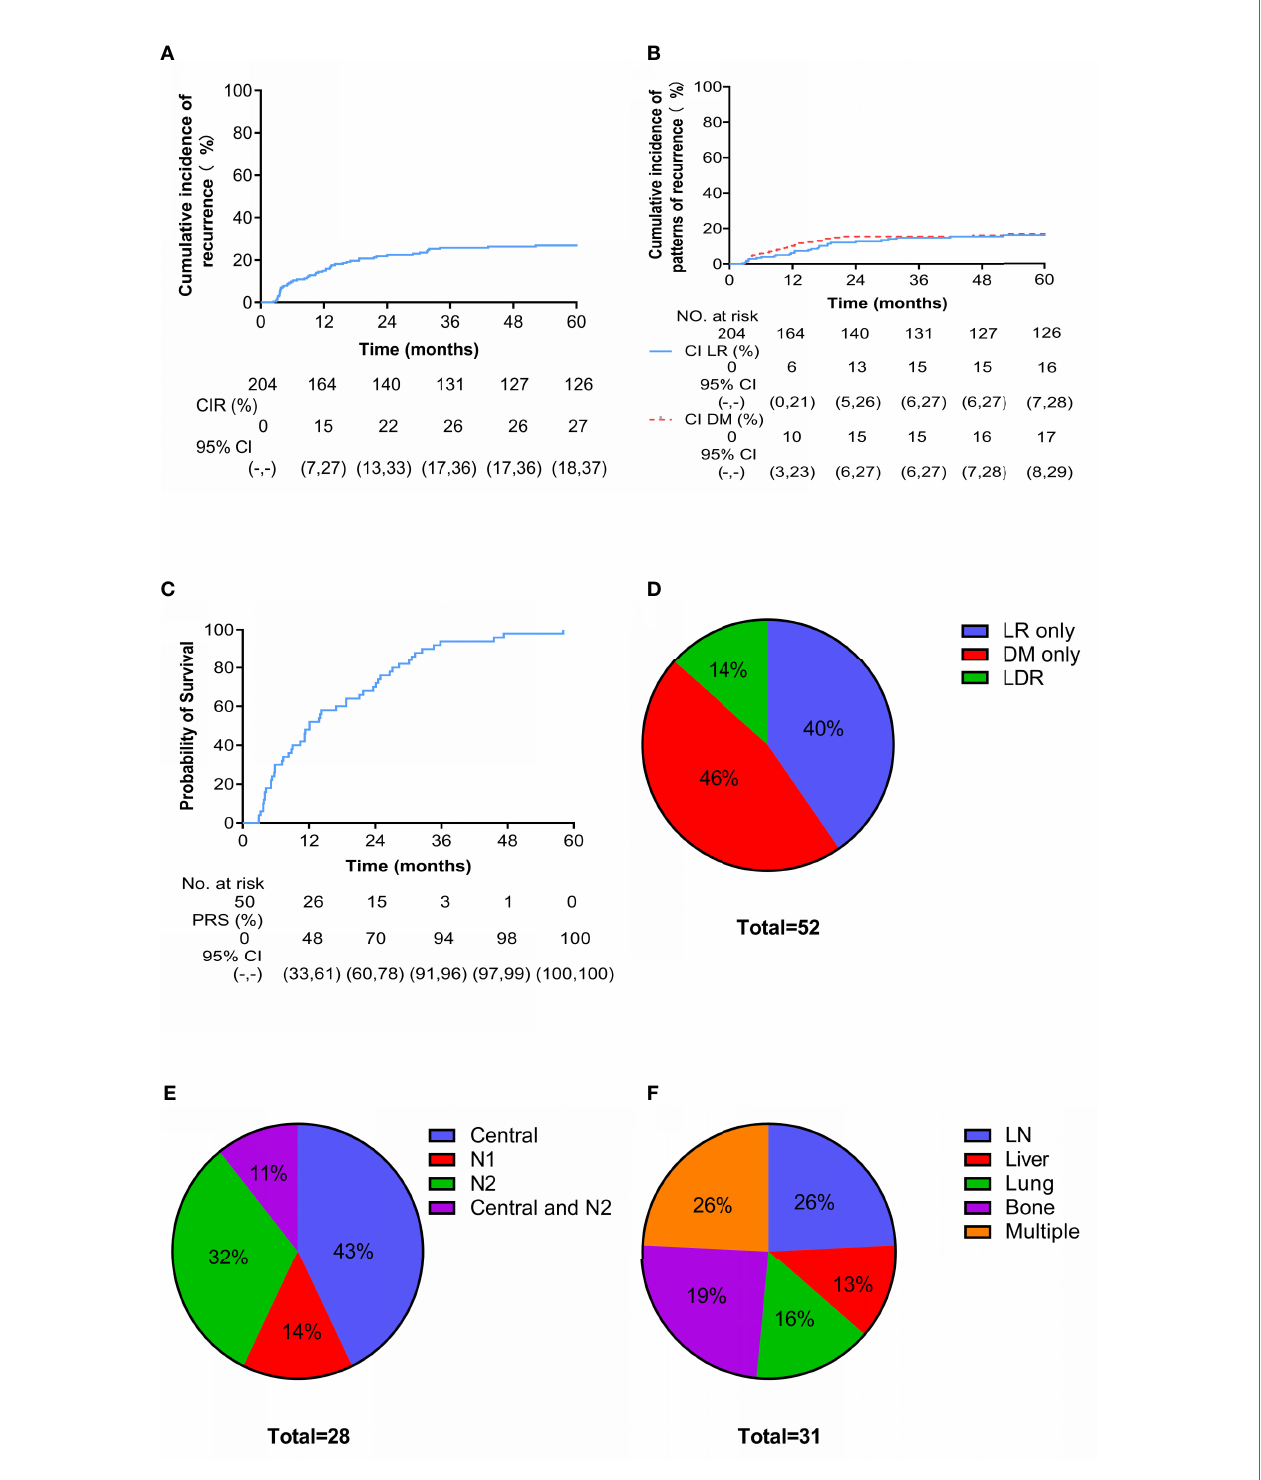
FIGURE 2 | Cumulative incidence and patterns of recurrence. Cumulative incidence of (A) overall recurrence and (B) locoregional (LR) versus distant metastasis (DM) since treatment. Cumulative incidence of (C) death after recurrence. Site-speci fi c patterns of (D) recurrence, (E) LR (N1 are pelvic lymph nodes and N2 are para-aortic lymph nodes or/and inguinal lymph nodes) and (F)